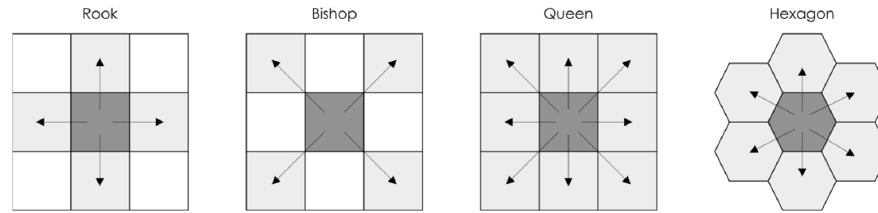
Figure 1. Neighborhood types in a grid system .